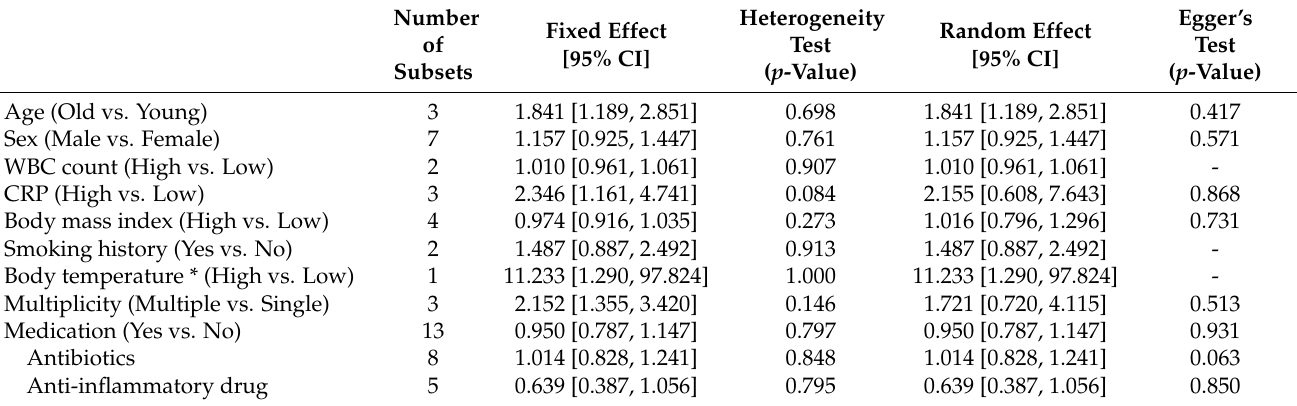
Table 3. Comparison of odds ratio in the recurrence of diverticulitis according to the patients’